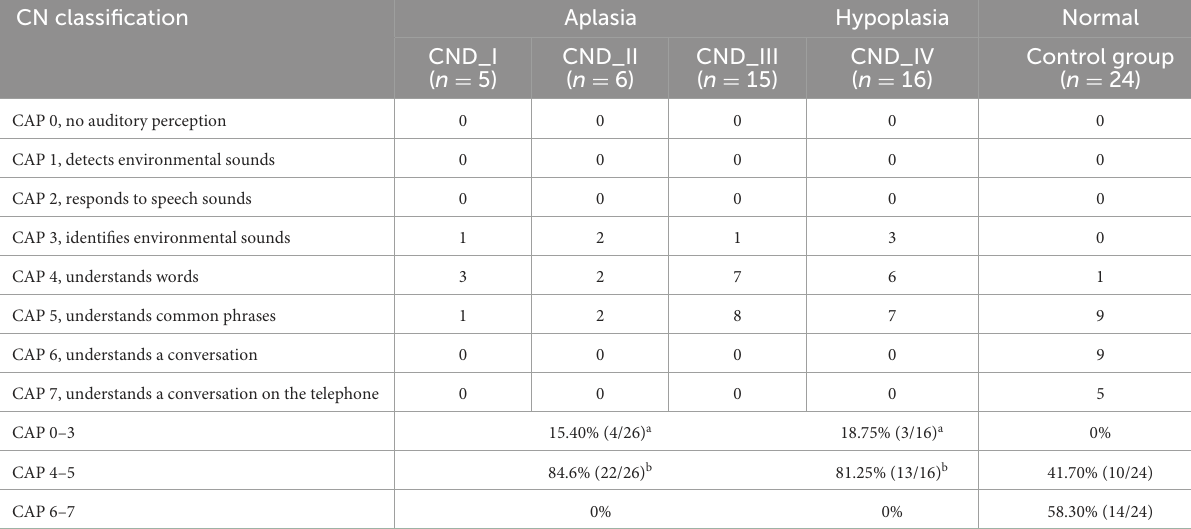
TABLE 4 CAP scores based on CN classification in 43 CI